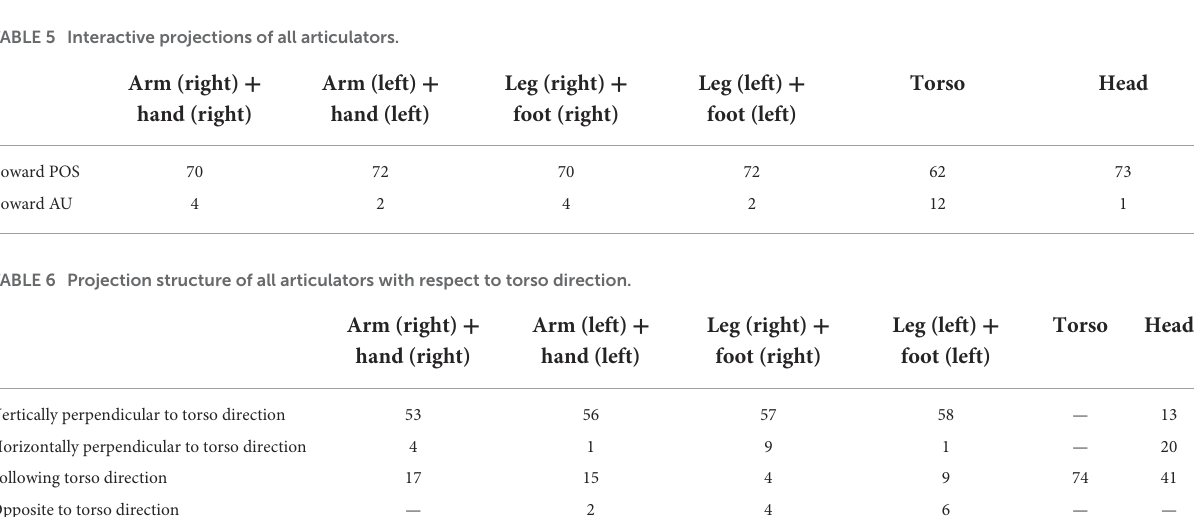
TABLE 5 Interactive projections of all articulators. Arm (right) +